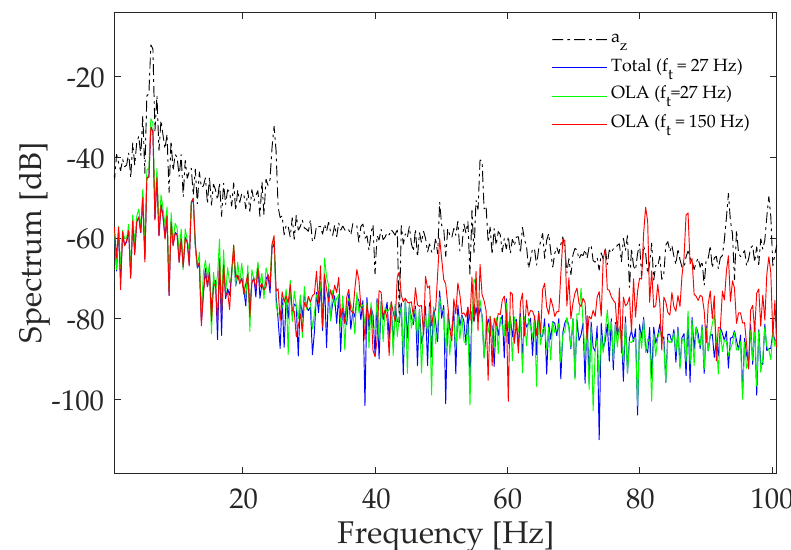
Figure 8. Comparison of spectra resulting from the windowed and non-windowed approach with respect to the spectral content of radial